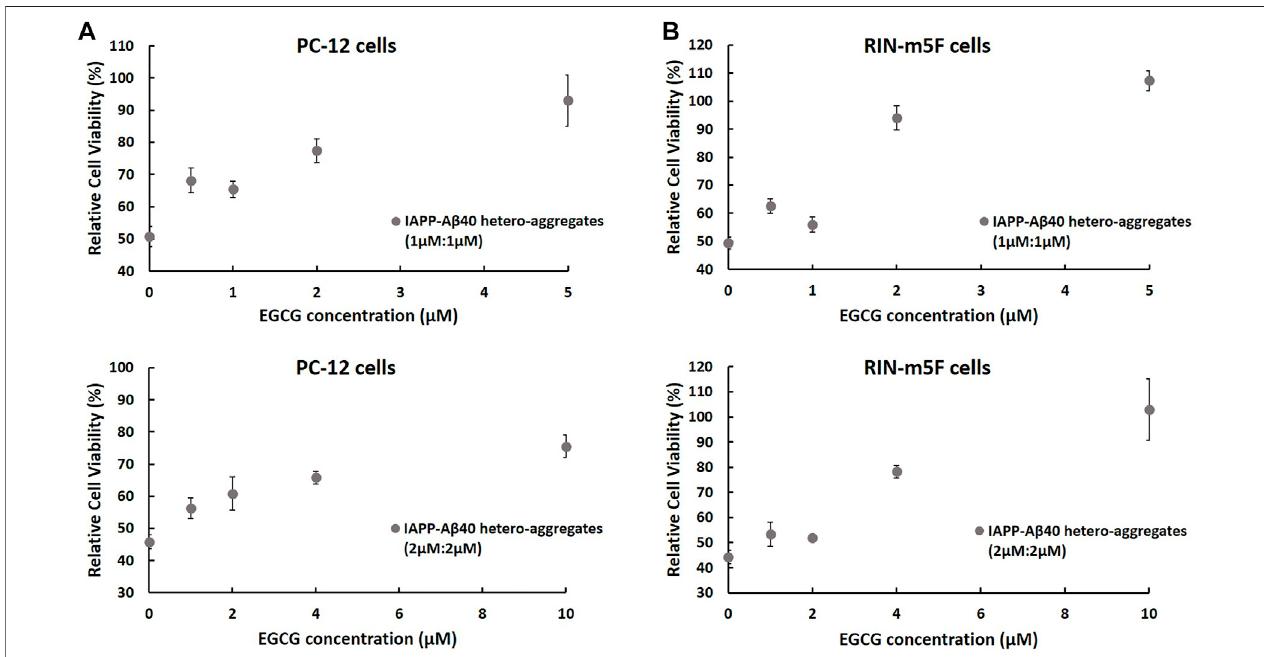
FIGURE9| MTTresultsshowingthenormalized cellviabilityratesof (A) PC-12 cellsand (B) RIN-m5F cellsaftertreatmentwith96Hours-agedIAPP-A β 40hetero- aggregates at two concentrations (1 µM:1 µM; upper panels) and (2 µM:2 µM; lower panels) in the absence and presence of increasing EGCG concentrations. EGCG concentrations were either lower than (0.25-fold and 0.5-fold), equivalent to, or higher than (2.5-fold) the total concentration of IAPP and A β 40. Normalized cell viability rates were calculated relative to control samples (cells without the peptide or inhibitor treatment). Negative control or the background values of the interference of EGCG with MTT only (no cells) were obtained from Supplementary Figure S11 , and subtracted from the absorbance values of cells treated with matching EGCG concentrations. Data represent mean ± SE ( n = 3), * p -value <